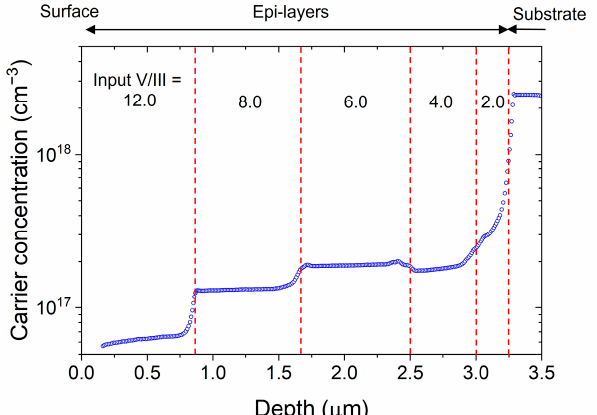
Figure A1. Active electron concentration as a function of depth for five growth steps of Si-doped GaAs films grown under an H 2 carrier gas ( H AsH 3 ) flow rate of 10 slm with different input V/III ratios measured using an electrochemical capacitance–voltage (ECV) profiler. The growth time for each layer was 30 s. Red dotted lines denote interfaces between Si-doped GaAs layers grown at different input V/III ratio.